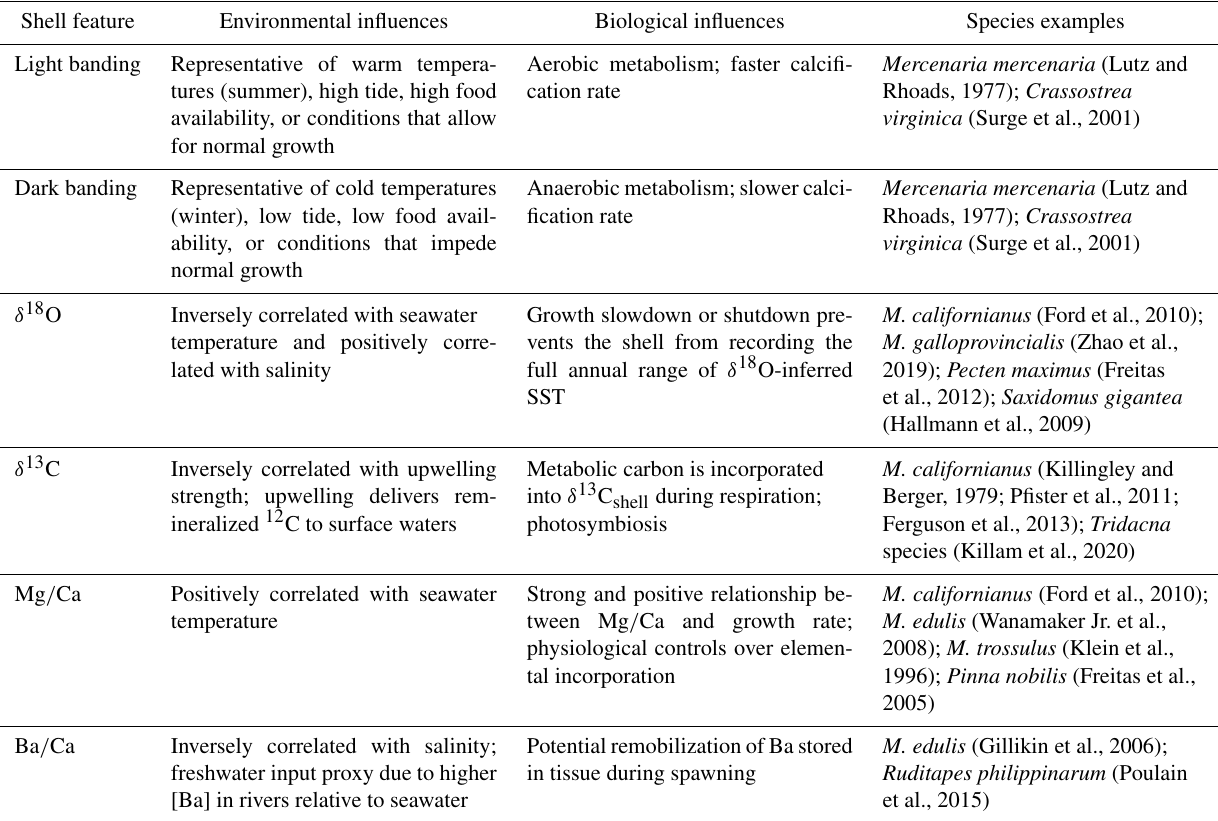
Table 1. Chemical and microstructural growth features recorded in bivalve shells and their environmental and biological influences. Species examples are not